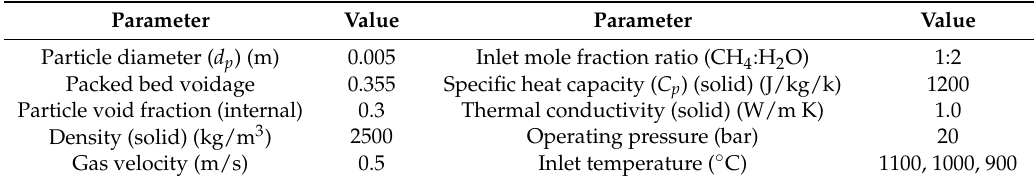
Table 1. Parameters for particle resolved direct numerical simulation